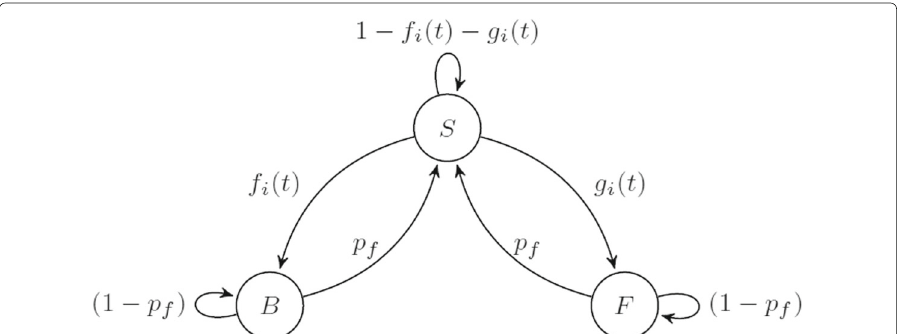
Fig. 1 A diagram of the model s.t. Susceptible (S) agents are exposed to the fake news and transact to a Believer (B) or a Fact-Checker (F) state according to transitionrates f i and g i , that are functions of the number of neighbors u i in a given state, a credibilityvalue α , and a spreadingrate β . B and F agents can go back to their S state because of a forgettingprobability p f ; Note that we do not admit the possibility for a Believer to transact to the Fact-Checker state because of an internal or external verification, as in our more ‘optimistic’ model presented in Tambuscio et al. (2015; 2018). In other words, we always set the so-called verifying probability for B → F to